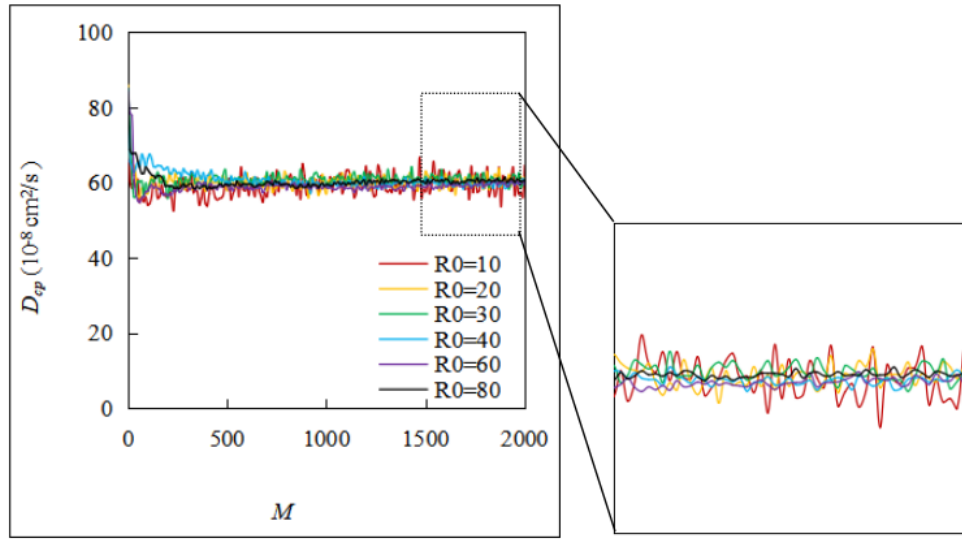
Figure 8. Effect of R 0 and M on the chloride diffusivity of cement paste: ( a ) effect of R 0 ; ( b ) effect of M .